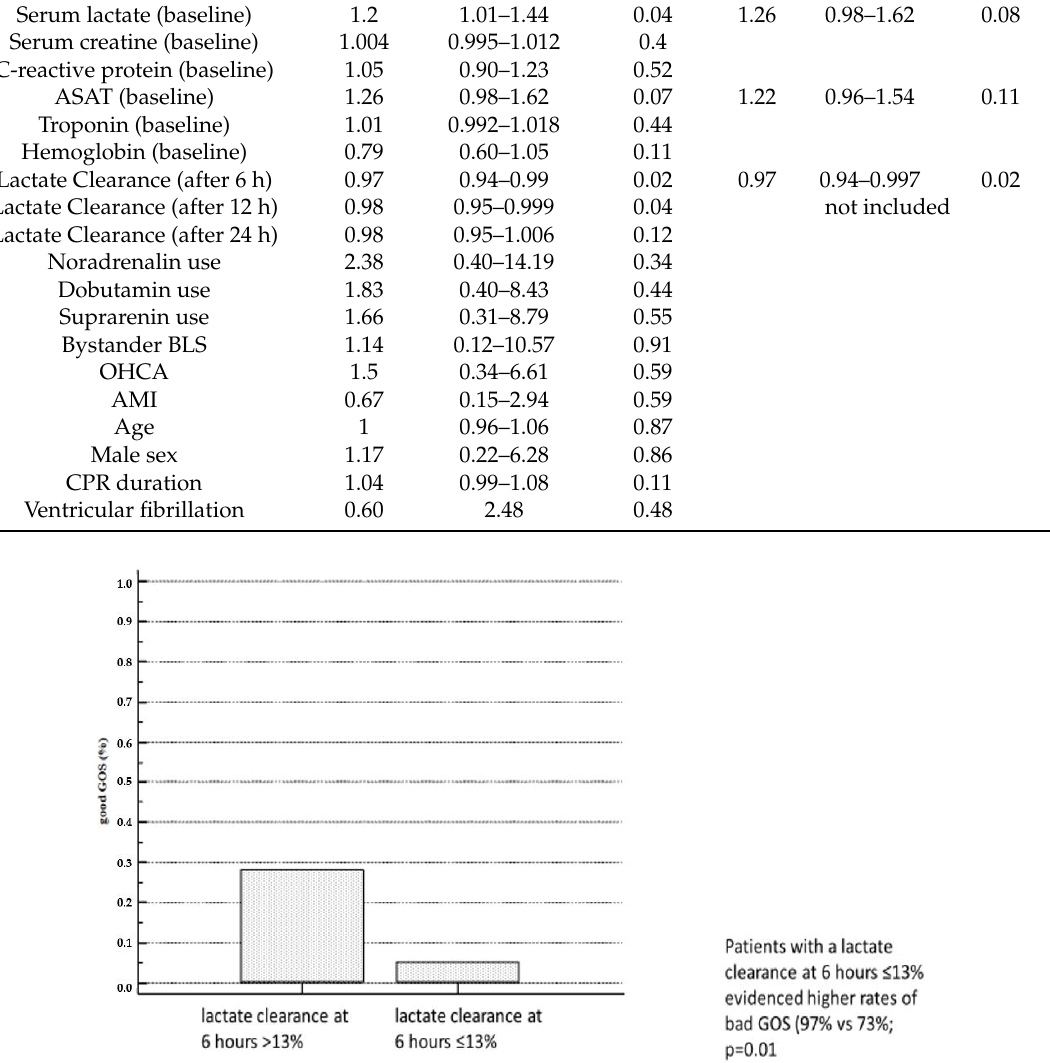
Figure 3. Patients with a lactate clearance at 6 h ≤ 13% showed higher rates of bad GOS (97% vs. 73%; p =